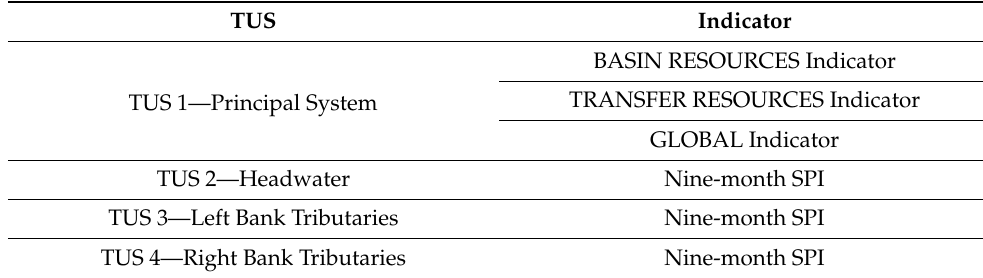
Table 11. Indicator of temporary scarcity. Source: own elaboration based on